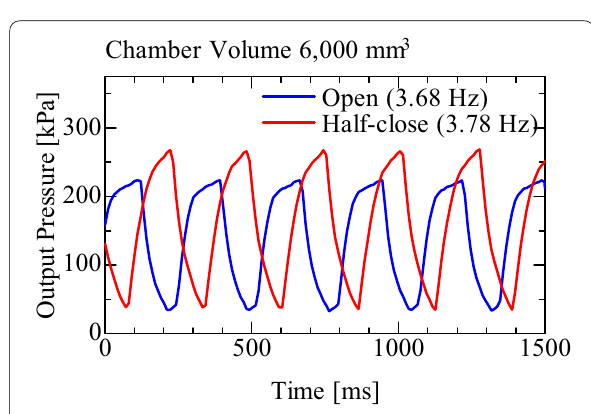
Fig. 12 Effect of the internal throttle valve